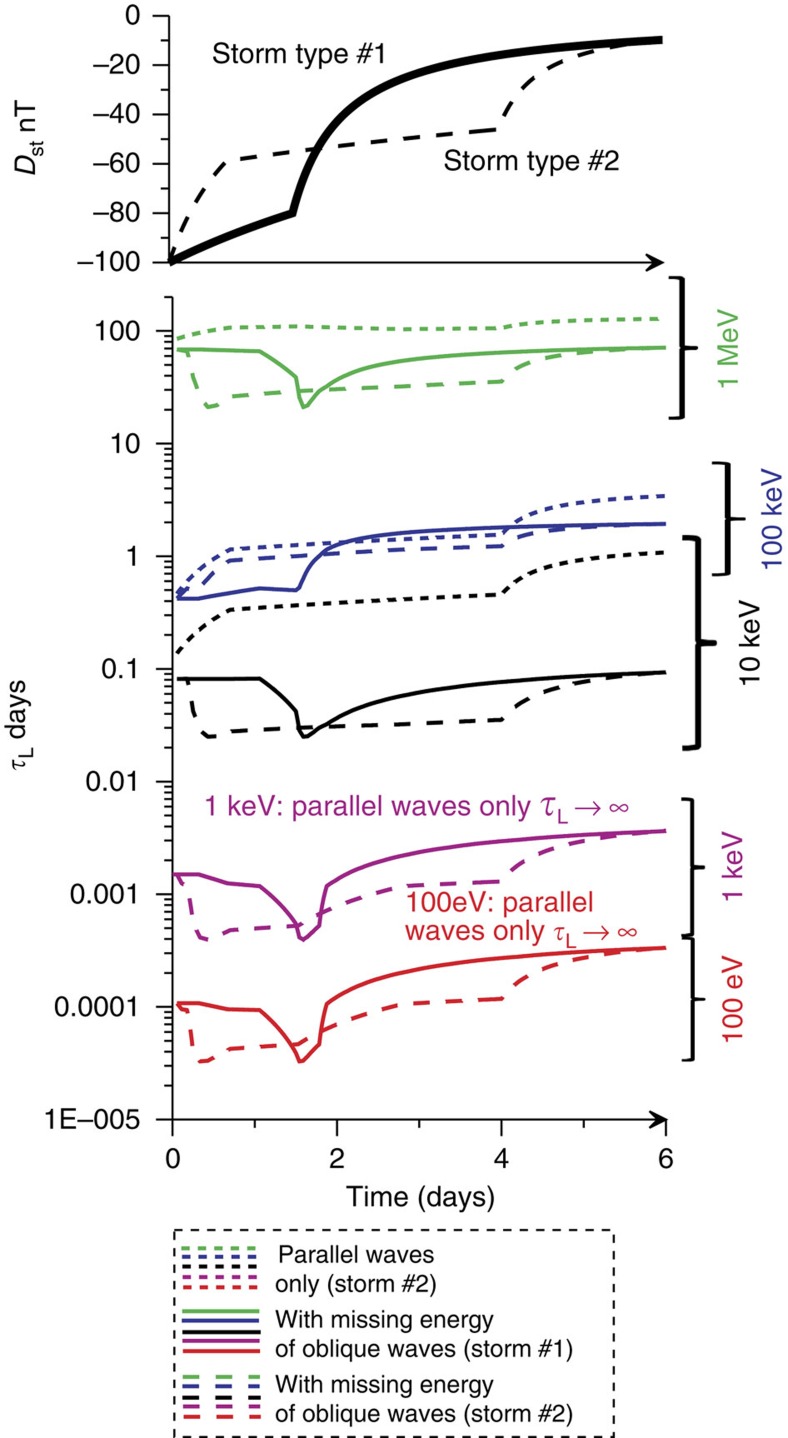
Variation of electron lifetimes in the course of geomagnetic storms.Two different temporal profiles of the Dst index are shown in the top panel, corresponding to two different types of storms. Bottom panels show the corresponding variation of electron lifetimes τL calculated for L∼5 at different energies (each colour corresponding to one energy). Dotted lines correspond to τL for parallel chorus whistler-mode waves (τL is infinite for 100 eV and 1 keV in this case) in the case of storm type #2. Solid (storm type #1) and dashed (storm type #2) lines show τL when using a realistic distribution of wave-normal angle. Five energies are shown: 100 eV, 1 keV, 10 keV, 100 keV and 1 MeV (for E≤ (>)1 keV, lifetimes are numerically calculated for electrons of equatorial pitch angle <60°(85°)).